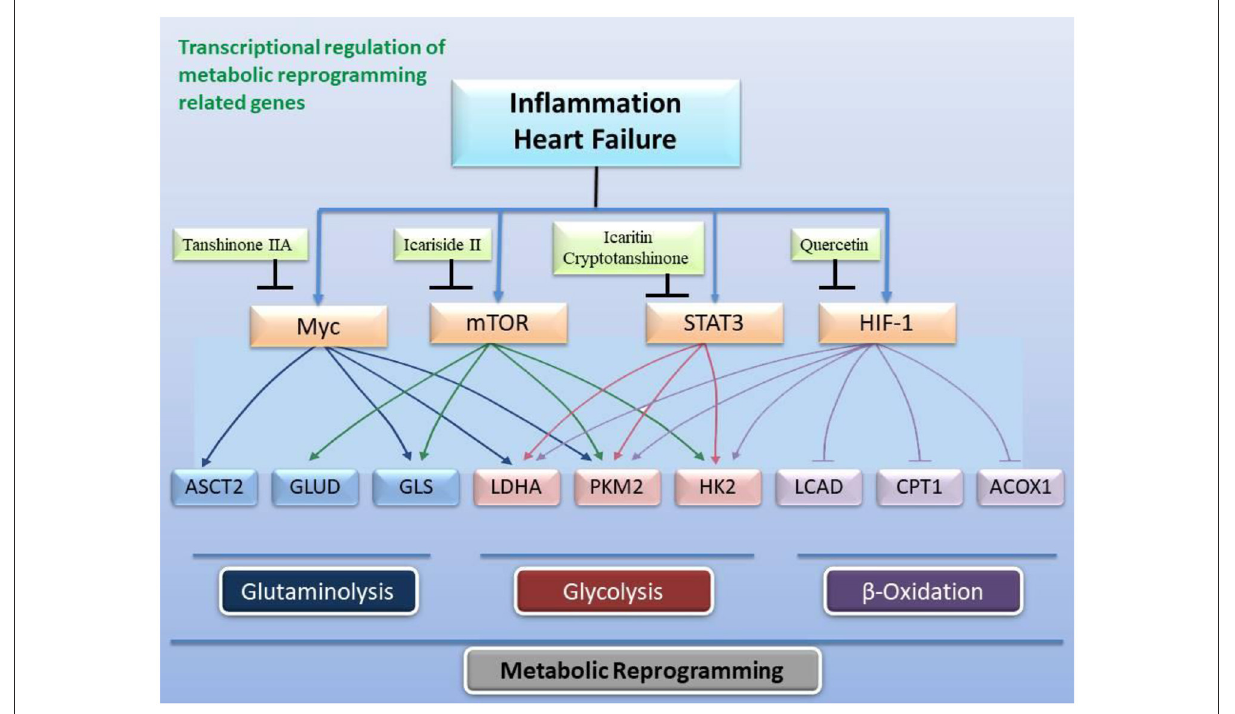
FIGURE5 Transcriptional regulation of gene expression related to metabolic reprogramming by active ingredients in classical formulas. Heart failure and inflammation trigger the activity of transcription factors c-Myc, mTOR, STAT3, and HIF-1 to change the expression and activity of enzymes related to glycolysis, fatty acid β -oxidation, and